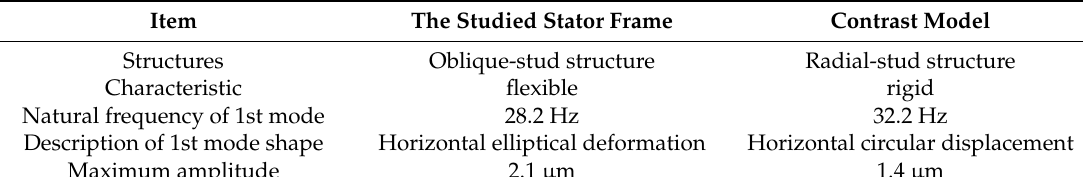
Table 5. Simulation results of different structures.